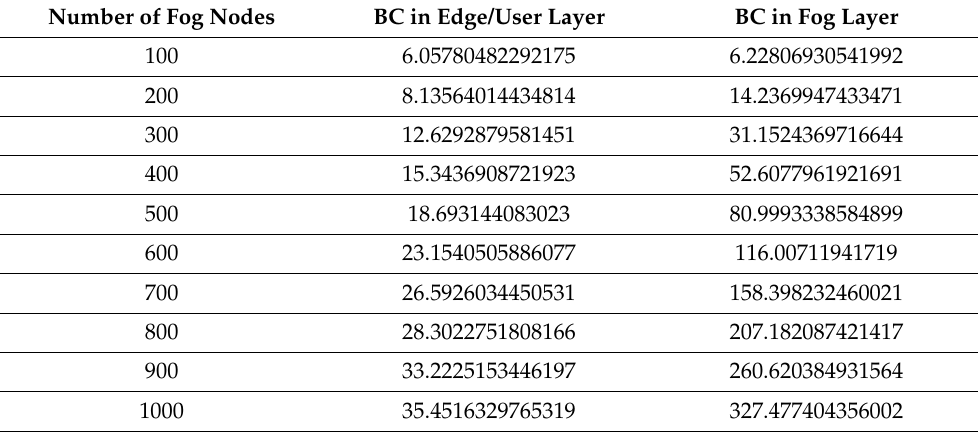
Table 6. FobSim simulation results with BC deployment at edge/user layer and fog layer. Number of Fog